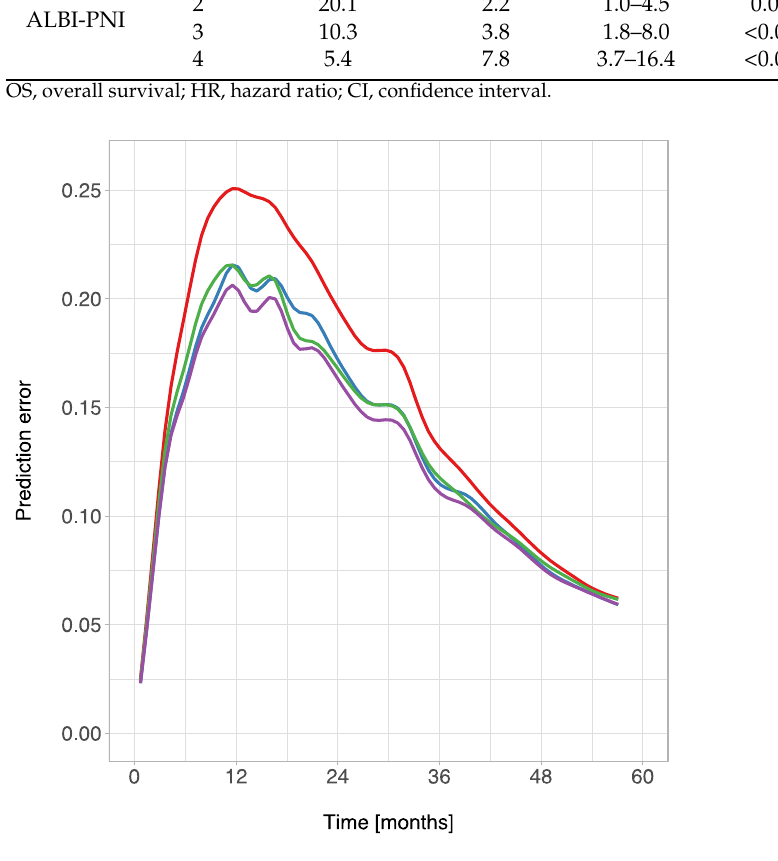
Table 4. Head-to-head comparison of the ALBI-PNI and different scoring systems.